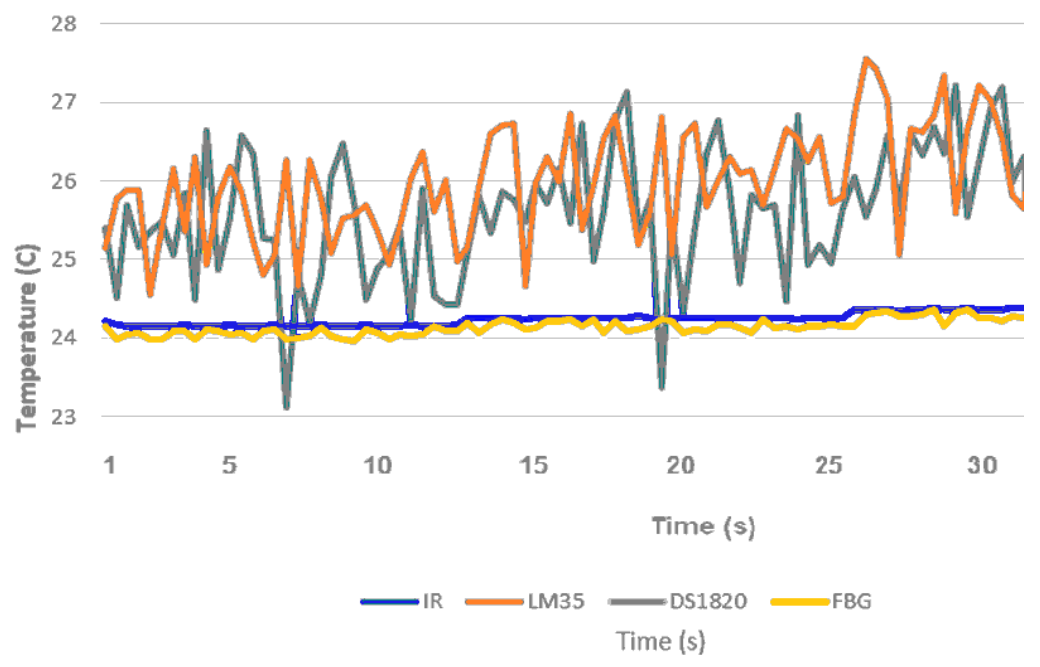
Figure 8. Temperature reading trends of FBG, LM35, and DS18B20 sensors in the battery charging test case.